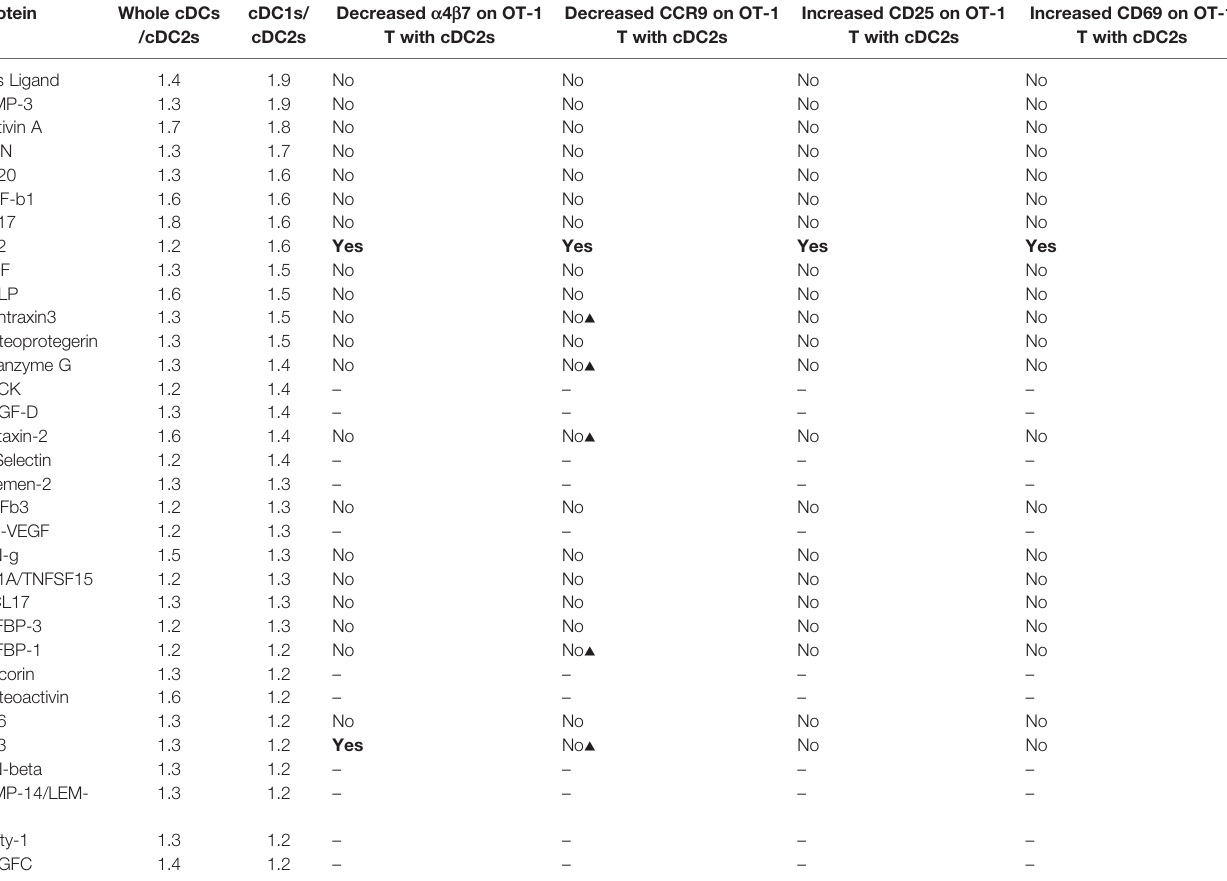
TABLE 1 | List of proteins differentially secreted by OT-1 T cells cultured with different peritoneal cDCs. Protein Whole cDCs